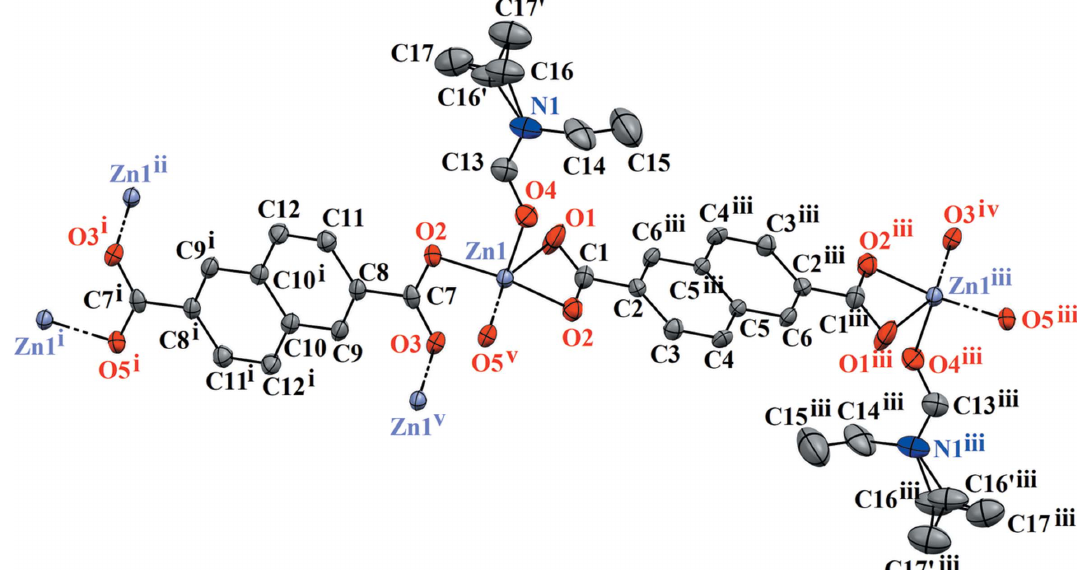
Figure 2 The molecular structure of MOF 1 , with displacement ellipsoids drawn at the 50% probability level, showing the labelling sheme and the disordered ethyl group of DEF. [Symmetry codes: (i) (cid:2) x + 1, (cid:2) y (cid:2) 1, (cid:2) z + 1; (ii) x + 1, y (cid:2) 1, z ; (iii) (cid:2) x (cid:2) 1, (cid:2) y , (cid:2) z + 2; (iv) x (cid:2) 1, y , z + 1; (v) (cid:2) x , (cid:2) y , (cid:2) z +